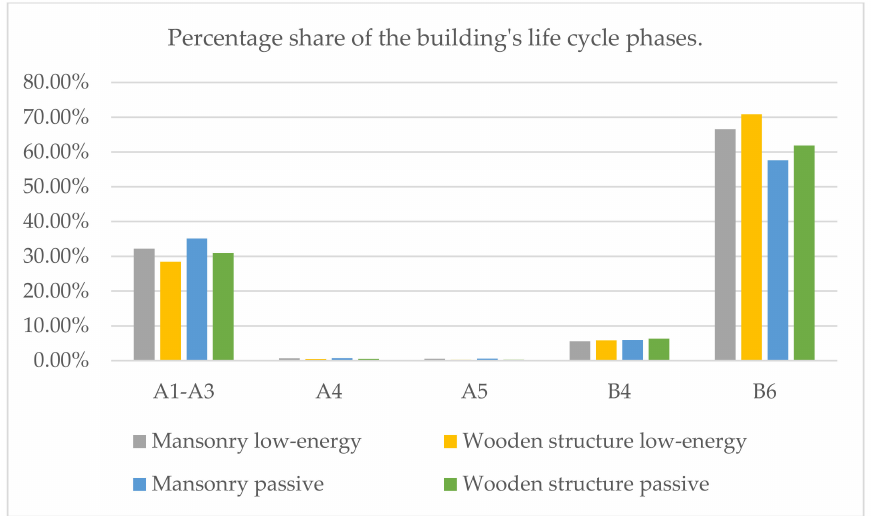
Figure 3. Analysis of single-family dwellings for selected life cycle stages of the building. The percentage of embodied energy for selected life cycle stages. A life cycle of 50 years was assumed for the calculations. Source: Based on